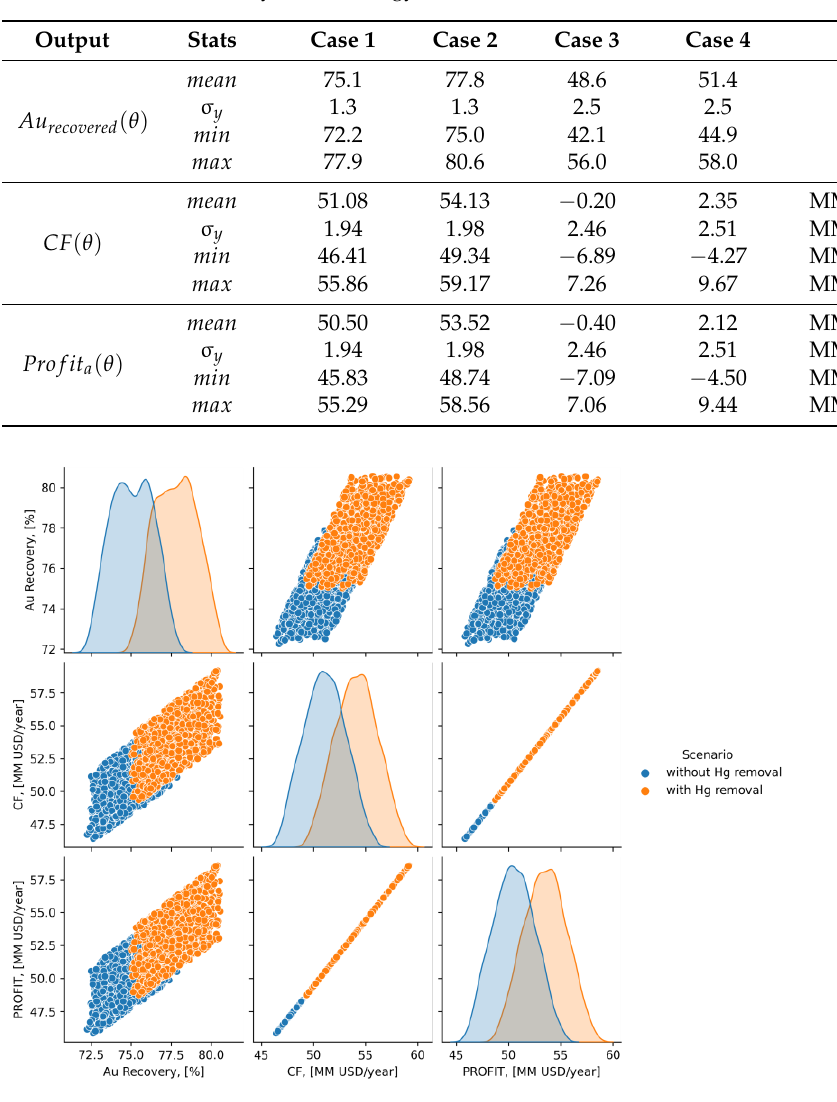
Figure 6. Pairwise bivariate distribution of the outputs for the systems using sodium cyanide as the leaching agent. The blue results correspond to the samples that did not include Hg removal, and the orange results correspond to the samples that included Hg removal.